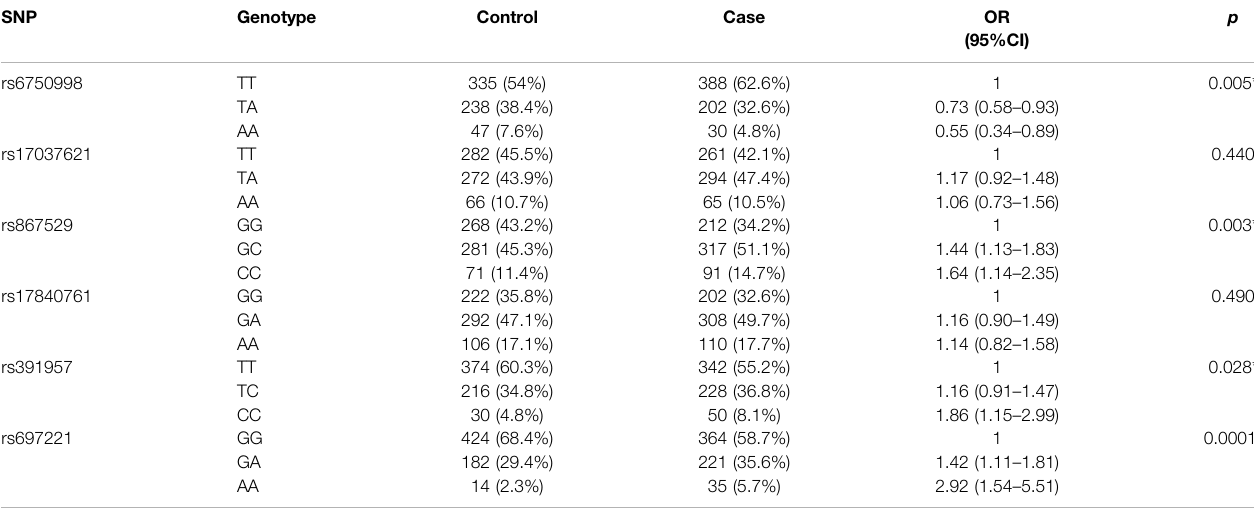
TABLE 4 | Genotype frequency distributions between lung cancer cases and healthy controls.